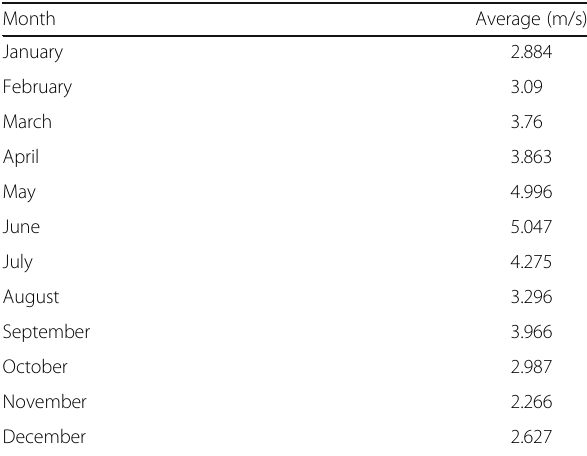
Table 4 Monthly average wind speed